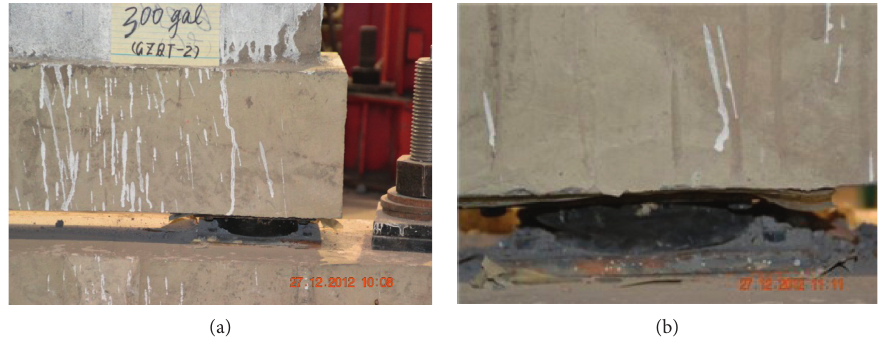
Figure 6: MLQT-2: (a) LRB limit of displacement state; (b) LRB broken state.